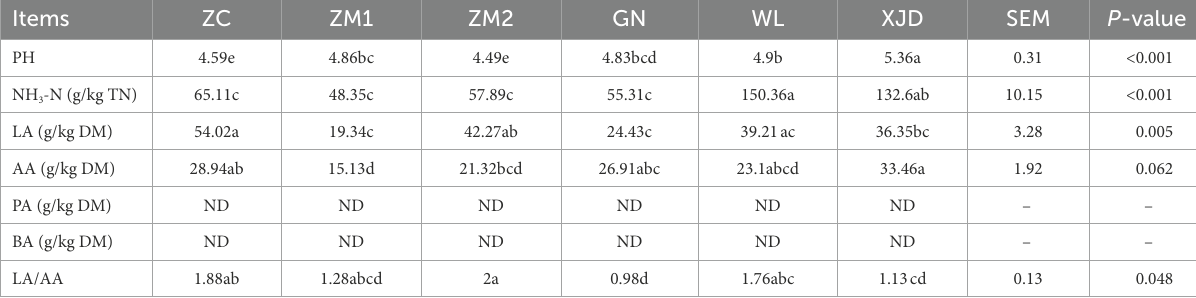
TABLE 3 Fermentation quality of alfalfa silage after 60 days of